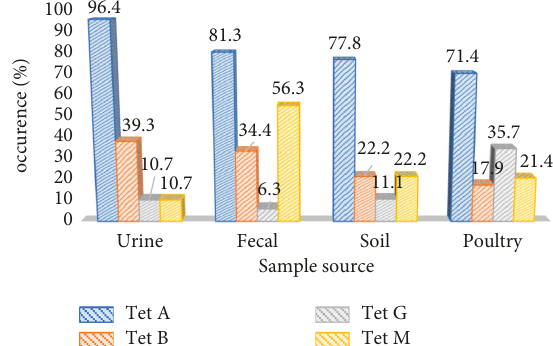
Figure 2: Occurrence variation of tetracycline-resistant determi- nants per source of E. coli isolate.